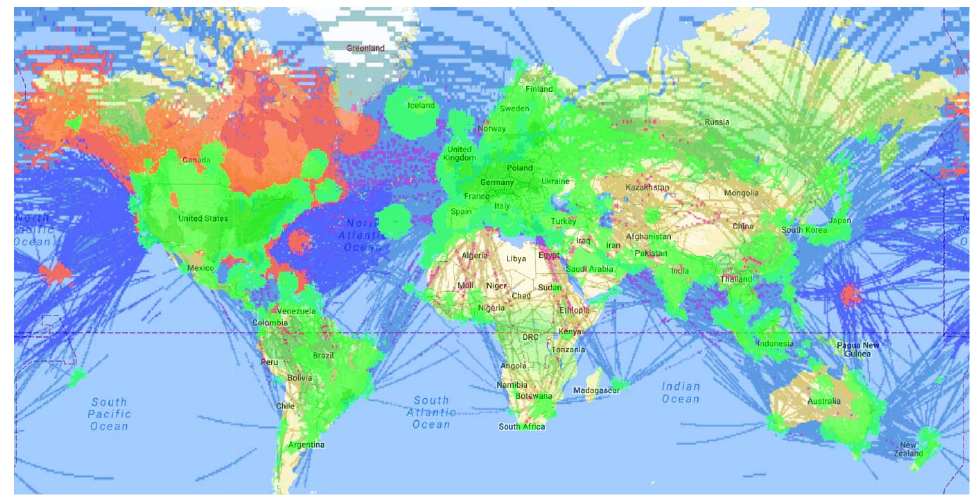
Fig. 1. A map of the airspace monitored by